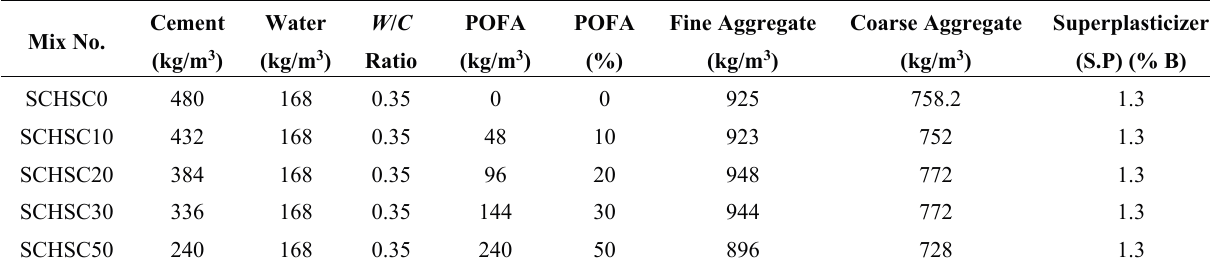
Table 3. Mix proportions of